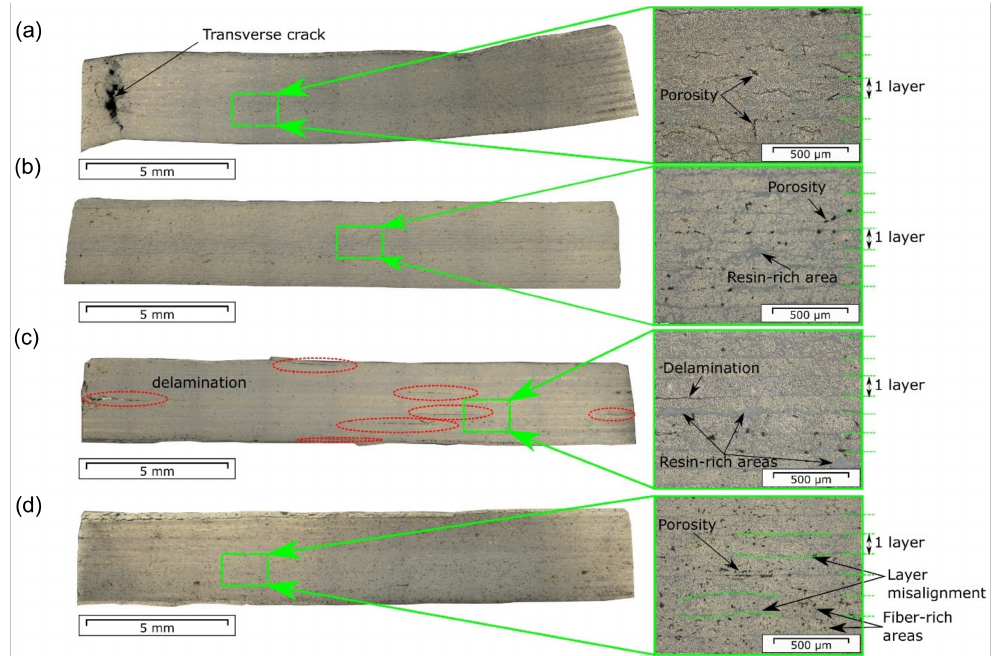
Figure 5. Micrographs of the laminate cross sections made prior to testing for: ( a ) c-5-330-01; ( b ) c-10-350-02; ( c ) f-5-330-04; ( d ) f-10-350-05. The red ellipses point out the interlayer